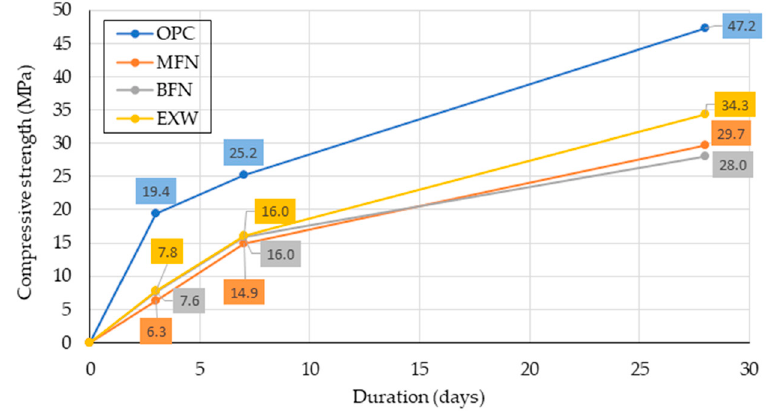
Figure 14. Compressive strength development of the mortar specimens.